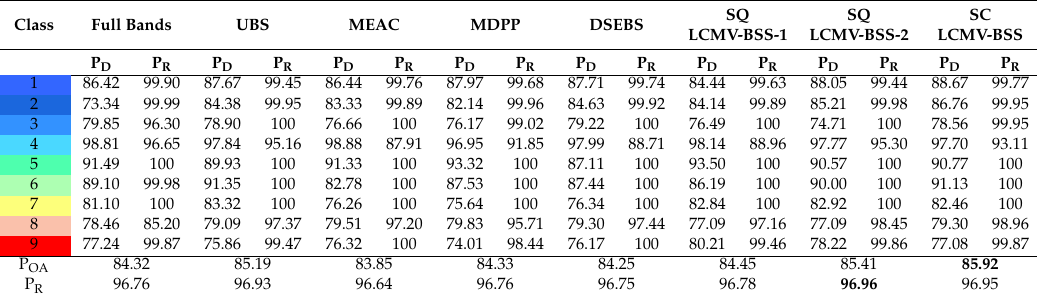
Table 5. P D , P OA , and P R calculated from the classification results in Figure 6 for University of Pavia.